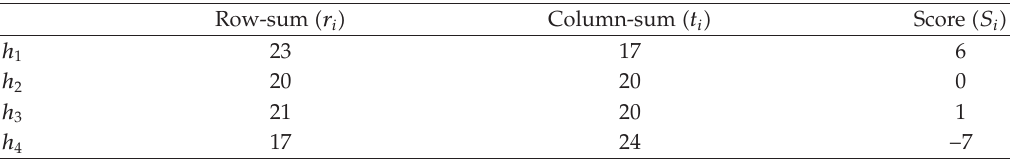
Table 2: Comparison table: U h 1